Question: Provide a publication-style caption for this figure.
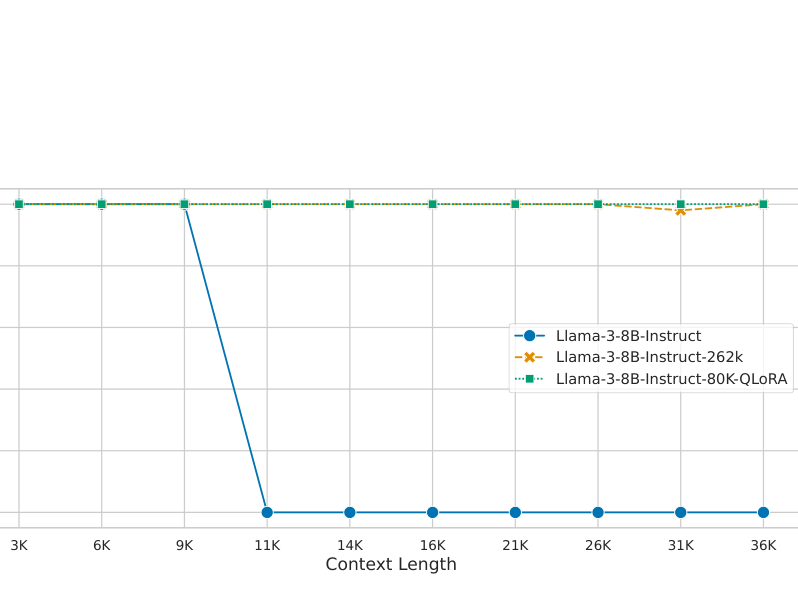
Answer: The accuracy of Topic Retrieval task.